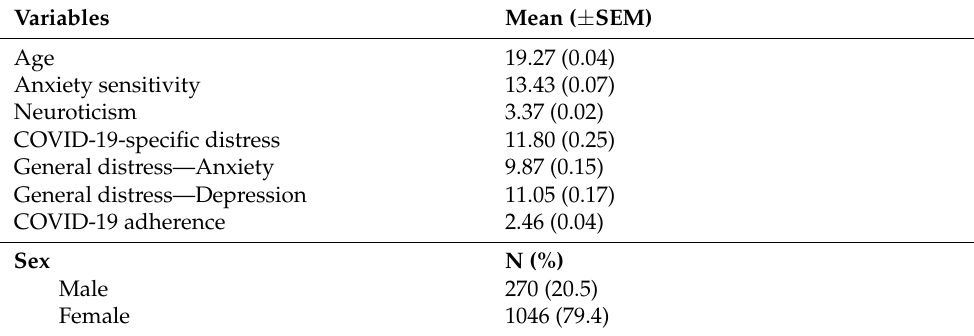
Table 1. Mean ( ± SEM) of the study population by key study variables.